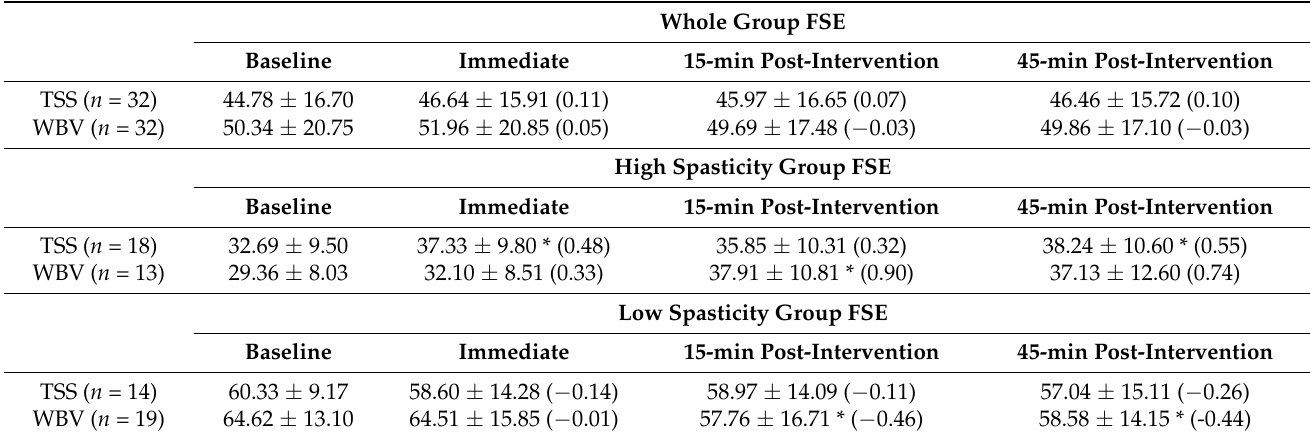
Table 1. Mean first swing excursion (FSE) by